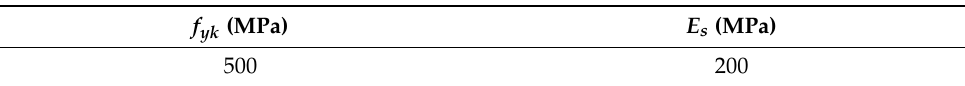
Table 3. Steel A500NR properties.